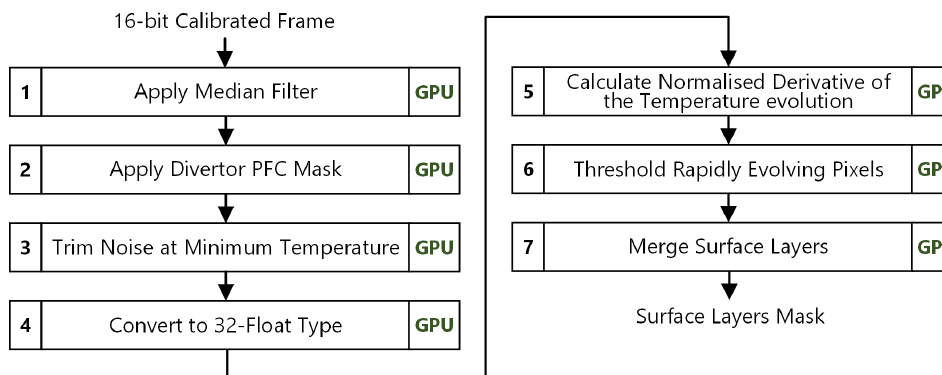
Figure 9. Surface layers detection pipeline.